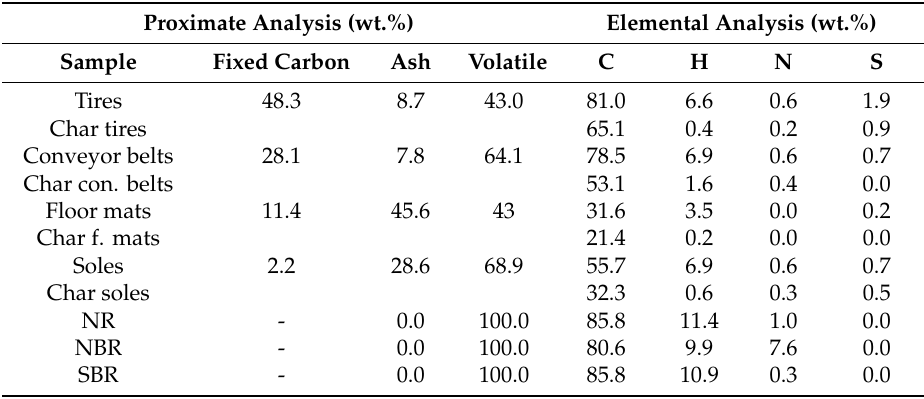
Table 2. Elemental composition (wt.%) and proximate analysis (wt.%) of raw materials used in the experiments, and relevant chars formed during pyrolysis. Proximate Analysis